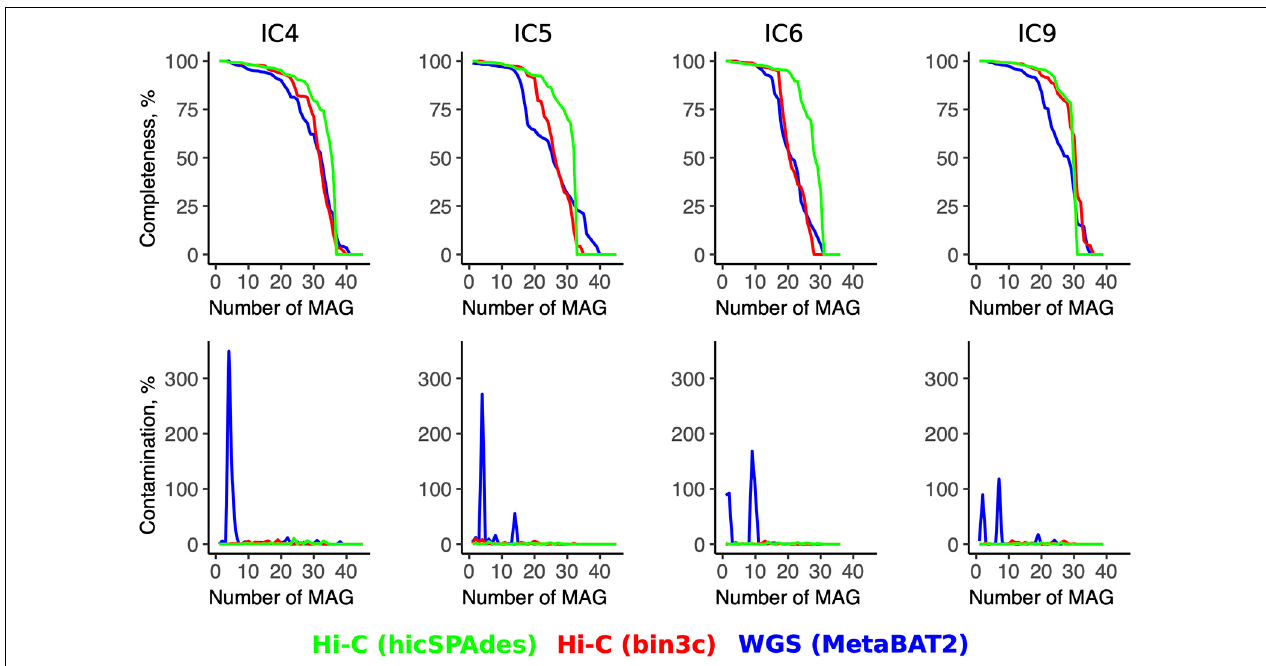
FIGURE 3 | Quality metrics for the Hi-C- and WGS-MAGs. The line plots show the values of MAGs’ completeness (top row) and contamination (bottom row) for each sample (column-wise) according to the WGS binning and two versions of Hi-C binnings (shown in three colors). For each sample, the MAGs are sorted in the order of decreasing